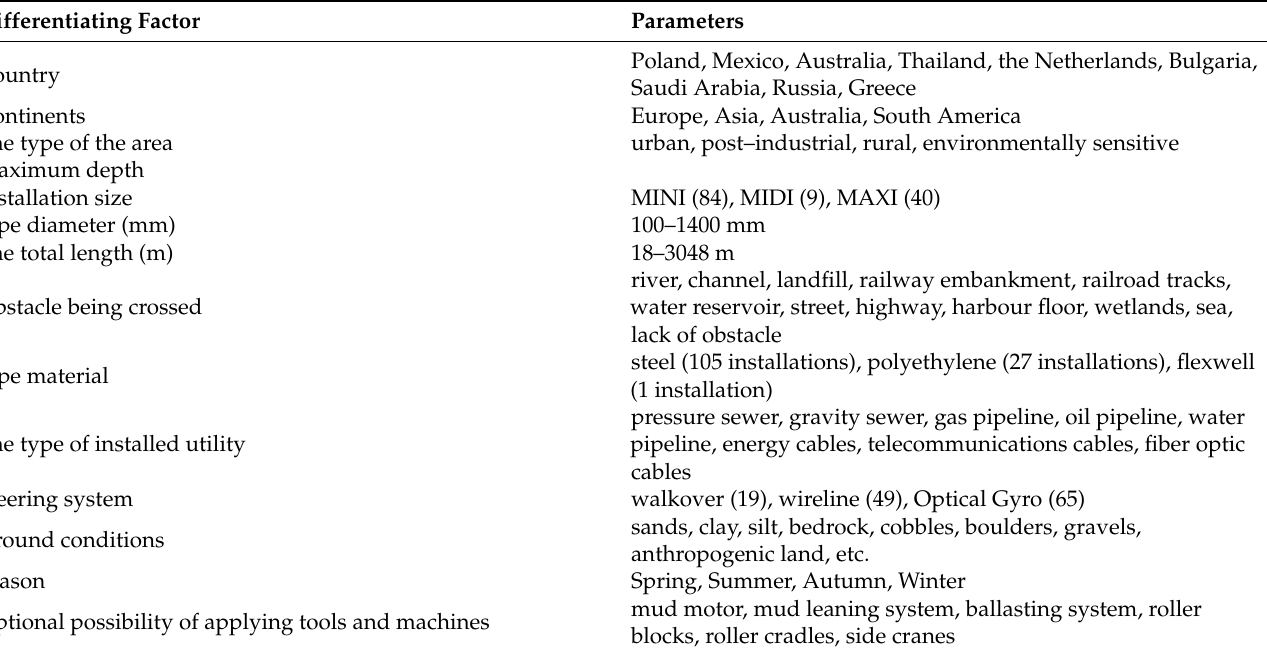
Table 2. The factors differentiating the individual projects from which the data were derived and their parameters. Differentiating Factor